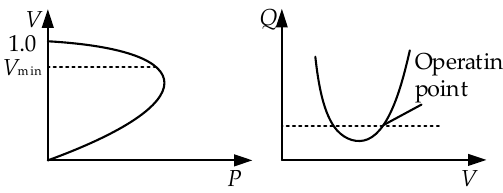
Figure 1. Power-voltage ( P–V )and voltage-reactive power ( V–Q )curve of bus.